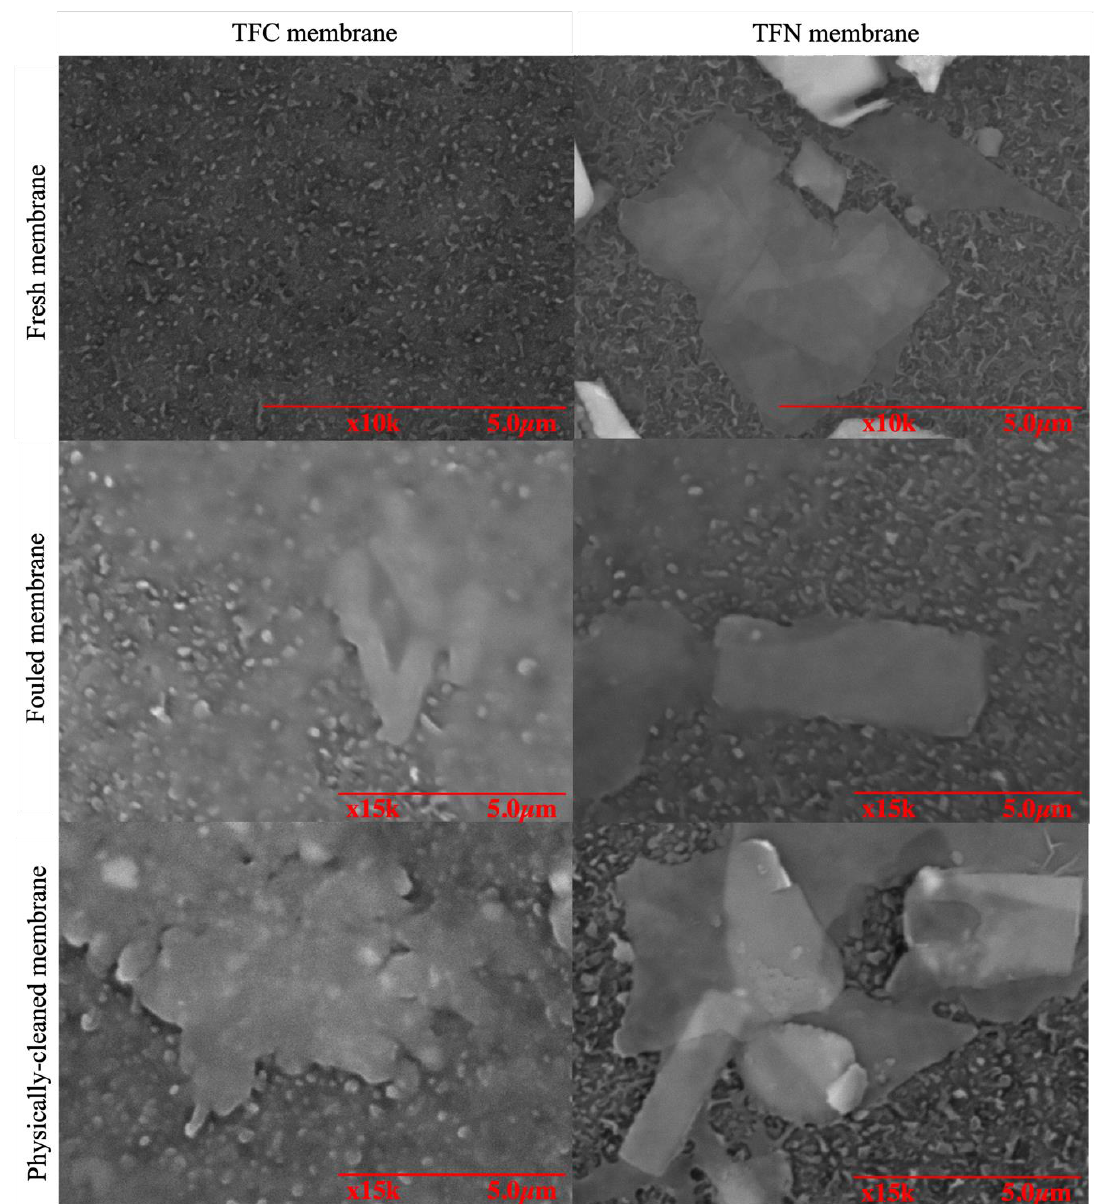
Figure 5. SEM images of TFC and TFN membranes of fresh, fouled and physically cleaned membranes.